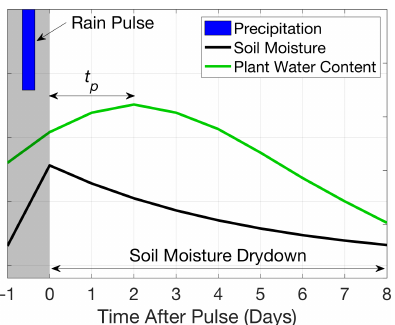
Figure 1. Schematic definitions of rain pulse, soil moisture dry- down period, and time to peak plant water content ( t p